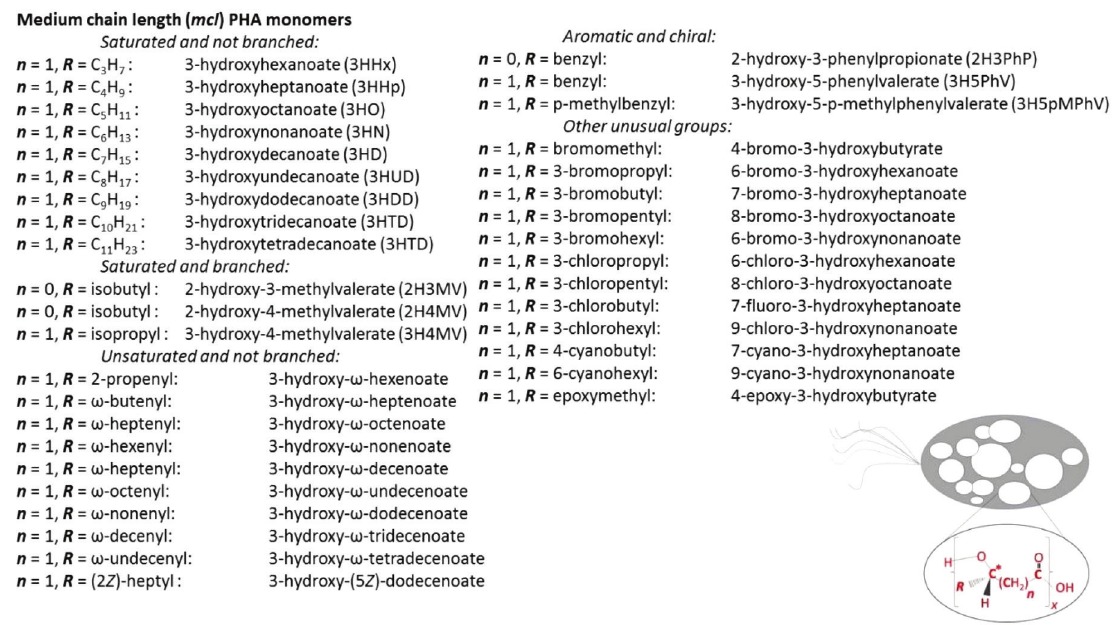
Fig. 3 – Monomers of mcl-PHA in PHA polyesters discussed in the present